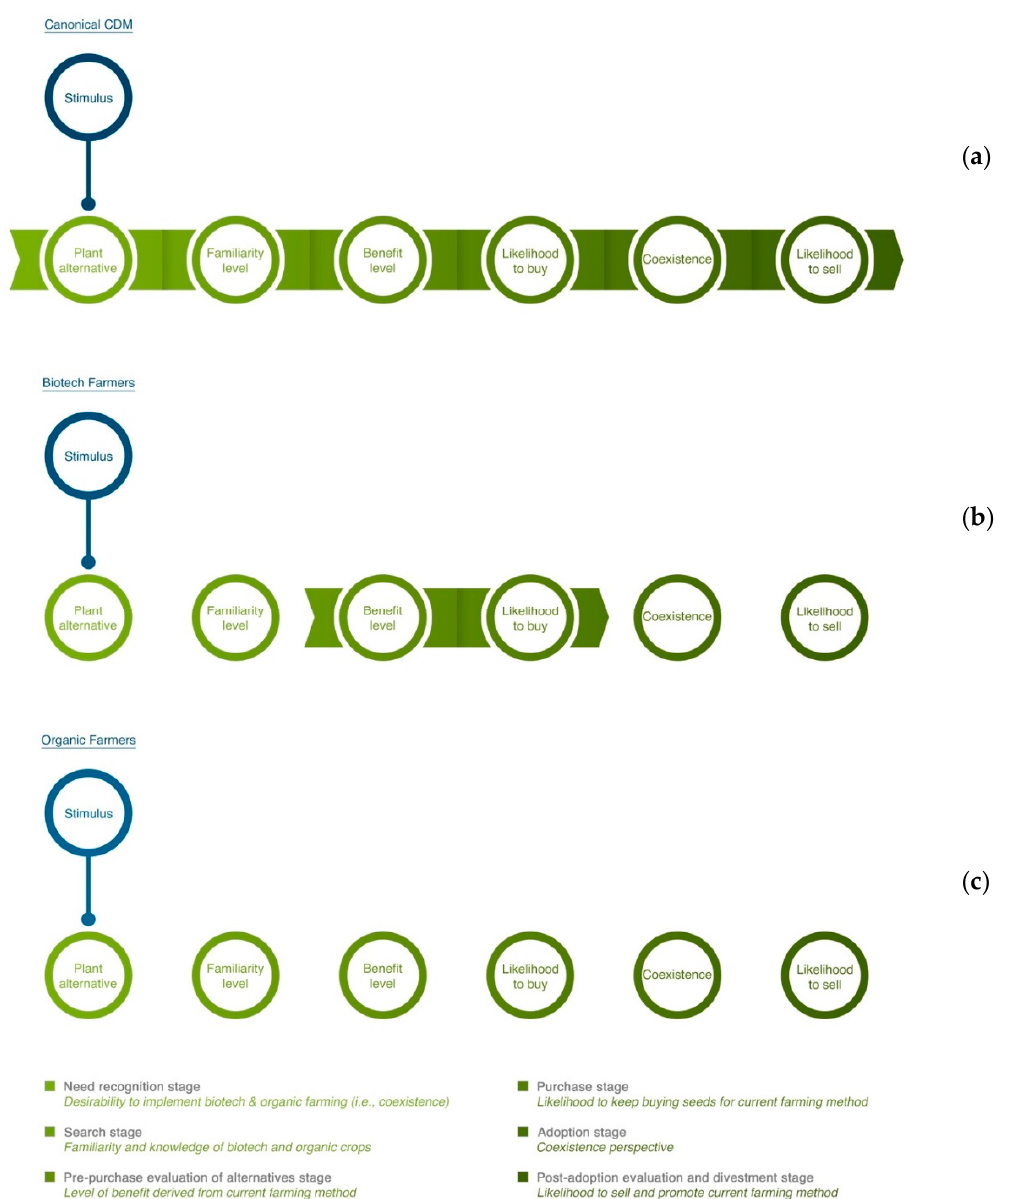
Figure 3. ( a – c ) Directed acyclic graph analysis of the canonical Consumer Decision Model ( a ) in the context of biotech farmers ( b ) and organic farmers ( c